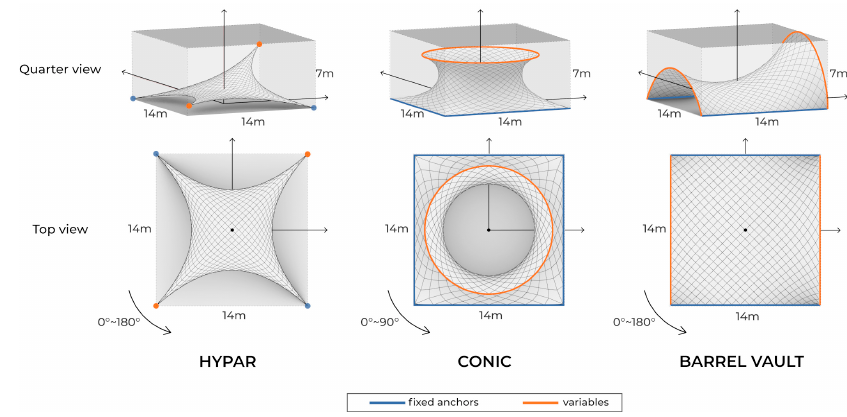
Figure 3. Boundary boxes of the TMA.